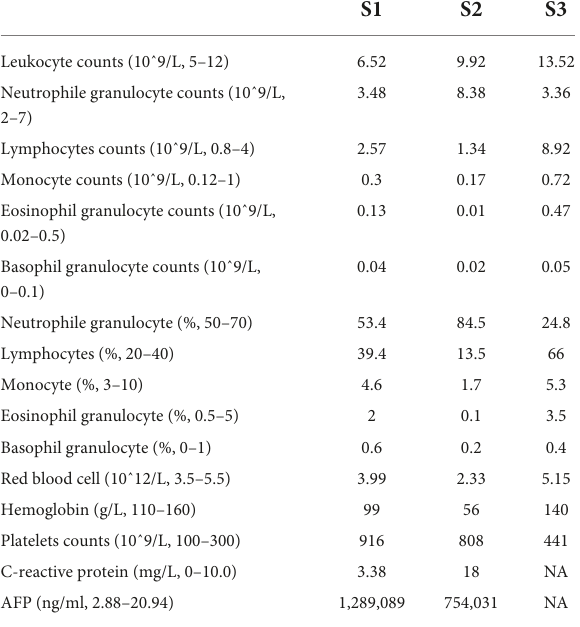
TABLE 1 Blood result of hepatoblastoma (HB) patients and normal control.